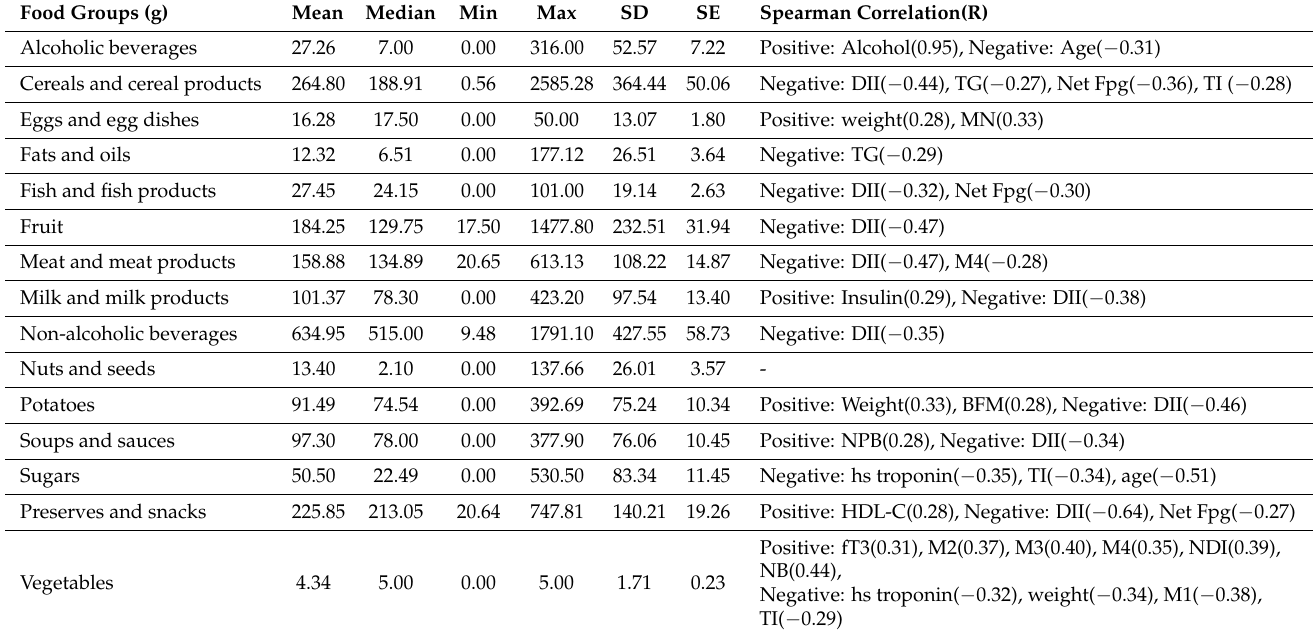
Table 4. Spearman’s correlation coefficient between different food groups derived by food fre- quency questionnaire and FETA program and anthropometric, biochemical, or DNA parameters (n = 53).